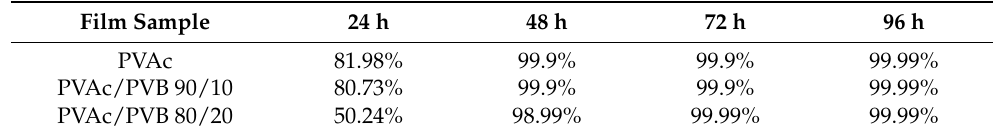
Table 2. DS of samples for various saponification